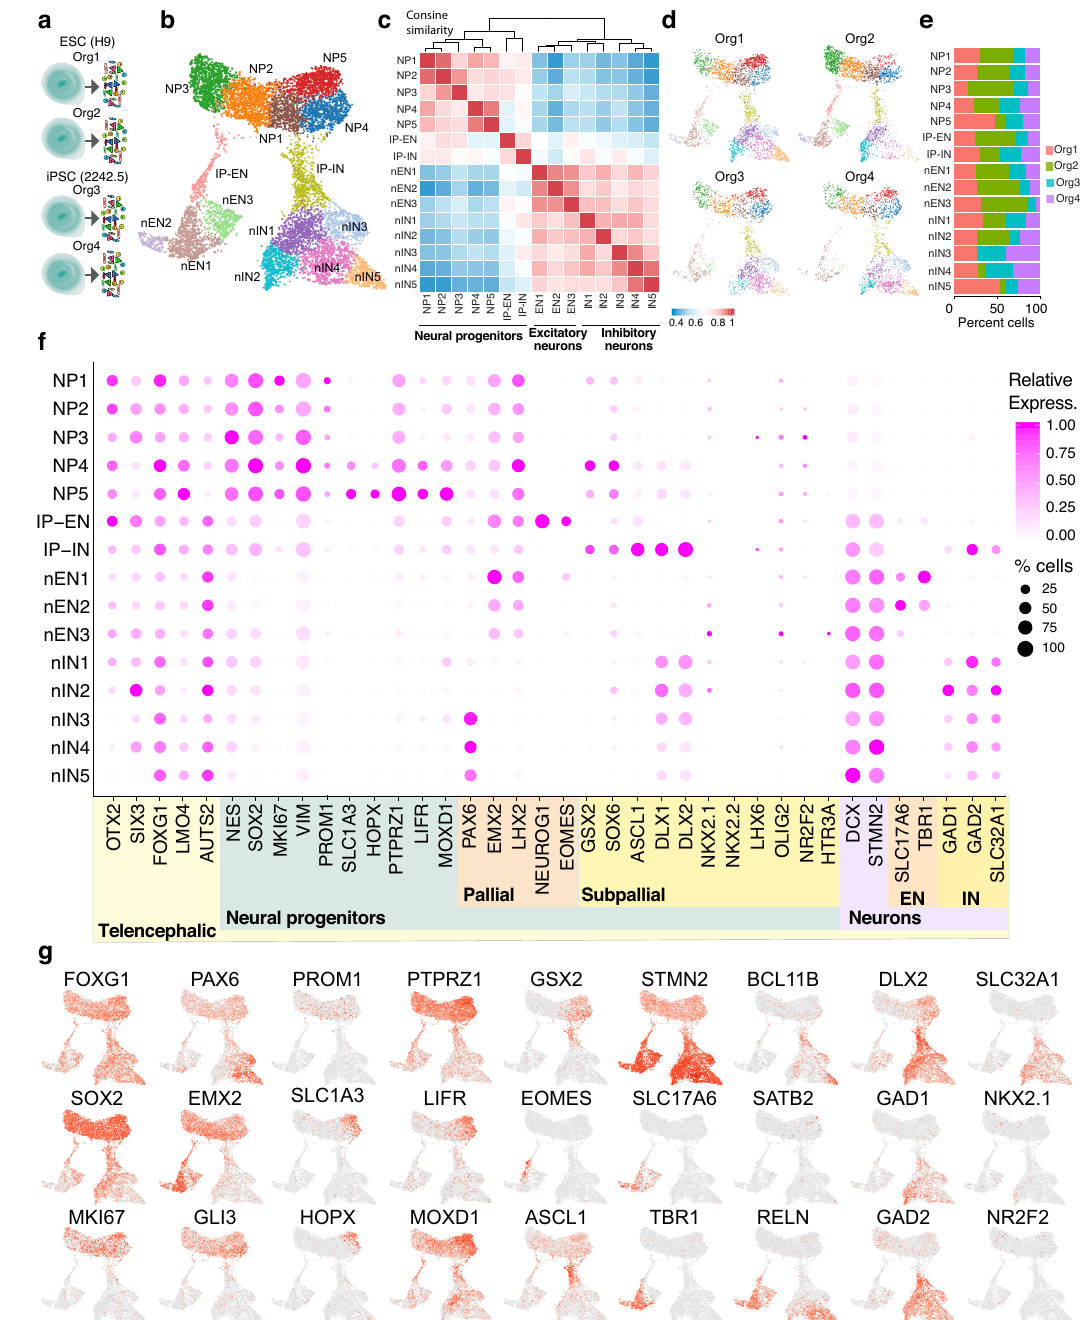
Fig. 2 | 1-month-old SNR-derived organoids consist of telencephalic neural progenitors and both excitatory and inhibitory neurons. a Cartoon depicting collection of single cells from individual organoids for single-cell RNA sequencing (elements were drawn by Coni Hoerndli Science Design). b UMAP visualization of unsupervisedcellclustering( n =4organoidsfromH9,and2242-5lines). c Heatmap of relative gene expression similarity between different cell clusters. d UMAP